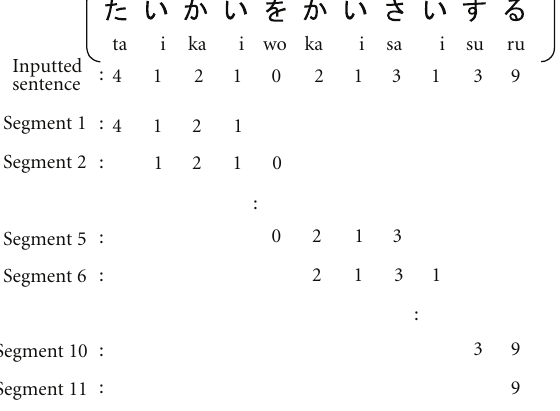
Figure 5: Example of division process.